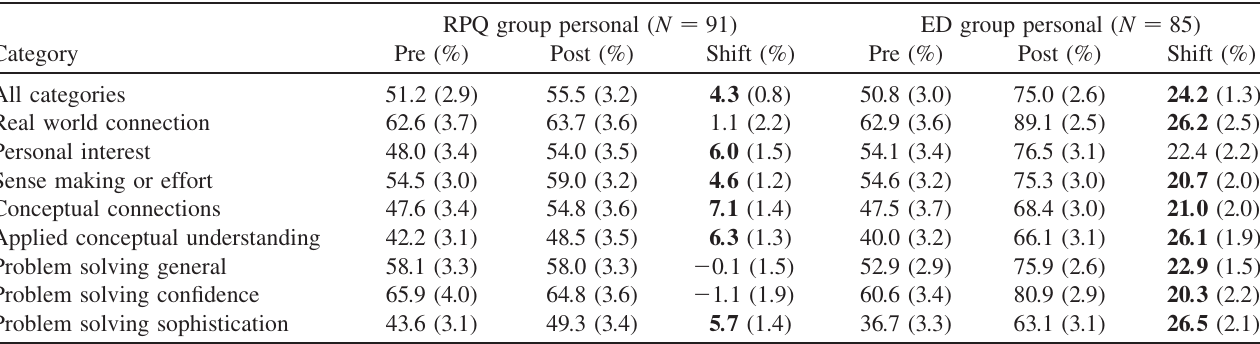
TABLE V. Scores ‘‘personal’’ by category of pre-CLASS and post-CLASS test for RPQ and ED group [standard error in parentheses; large shifts ( p < 0 : 05 ) in bold font].